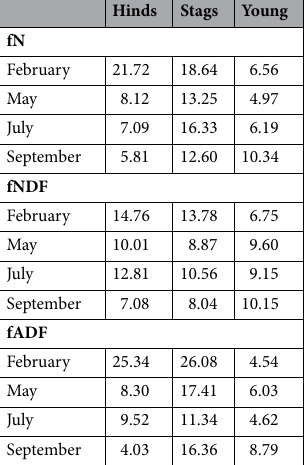
Hinds Stags Young